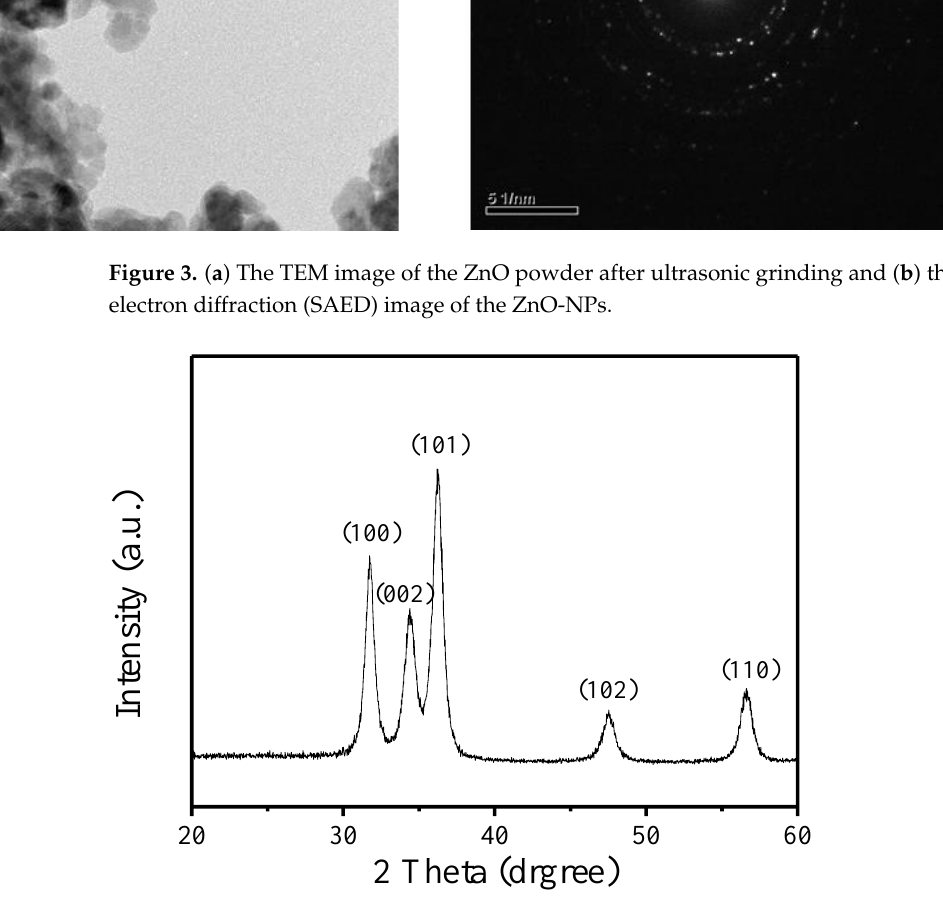
Figure 4. The XRD pattern for ZnO nanoparticles that are deposited on glass. To measure NH 3 gas, the sensor response is calculated as [(R air − R gas )/R air × 100%], where R air is the resistance in air and R gas is the resistance in the target gas: NH 3 . Figure 5 shows the sensor response for the ZnO-NPs/MEMS gas sensor. During the measurements, 1 ppm (parts per million, ppm), 0.4 ppm, 0.3 ppm, and 0.1 ppm NH 3 were introduced into the airtight chamber at room temperature. Using this definition, the respective sensor response is around 39.7%, 21%, 17% and 6.9% for a concentration of NH 3 gas of 1 ppm, 0.4 ppm, 0.3 ppm, and 0.1 ppm. The sensor response increases as the NH 3 gas concentration increases. The response time and recovery time are not decreased at room temperature.